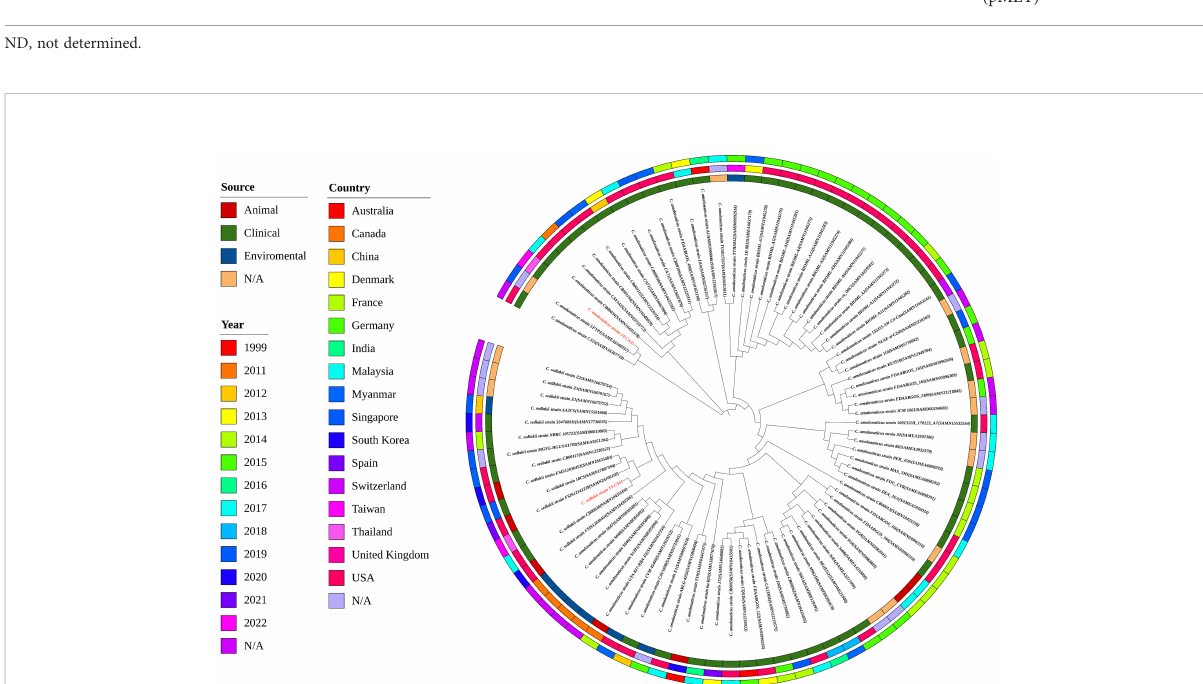
FIGURE 4 Roary matrix-based gene sequence analysis of 86 Citrobacter isolates. The source of the isolates is shown in the inner ring. The location of the isolates is depicted in the middle ring and the year of the isolates is indicated by the outer ring. Isolates in this study including SY-CS04 and SY- CA35 were colored in